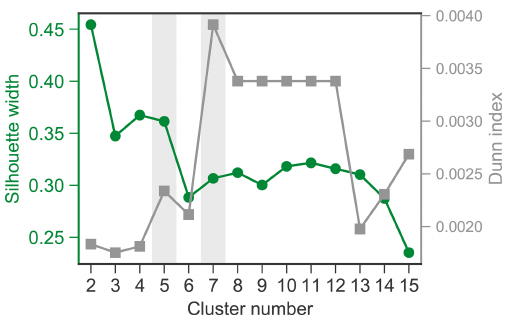
Figure A2. Silhouette width and Dunn Index for cluster numbers ranging from 2 to 15.